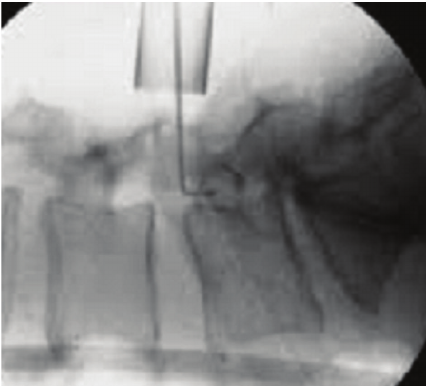
Figure 2: Minimally invasive decompression of lumbar stenosis with fluoroscopy confirmed placement of tubular